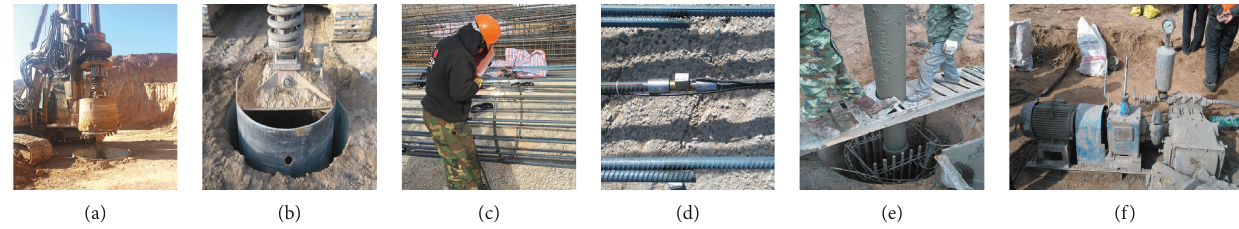
Figure 3: (a) Drilling rig. (b) Drill bit. (c) Steel reinforcement cage. (d) Reinforcement stress gauge. (e) Pipe. (f) Grouting equipment.